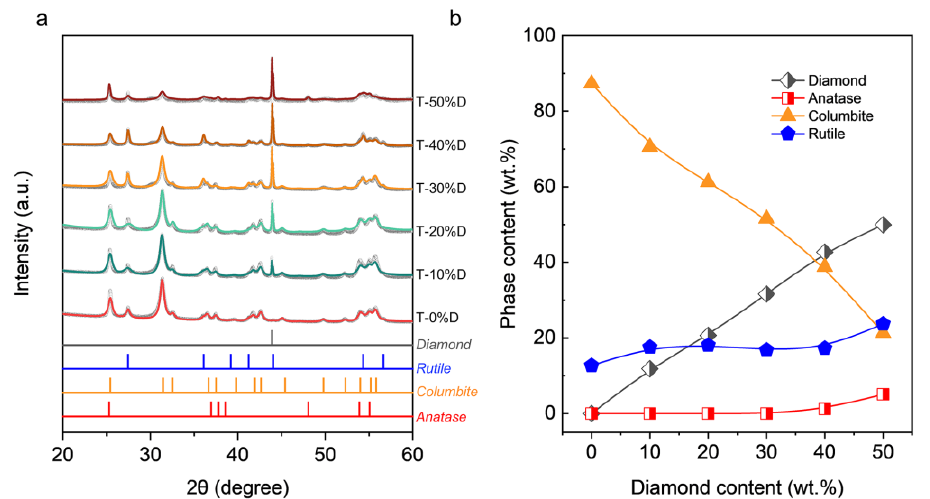
Figure 2. ( a ) Experimental and Rietveld refined XRD patterns of the recovered samples of TiO 2 - diamond composites sintered at 6 GPa and 450 °C. ( b ) Phase content variation as a function of diamond content.